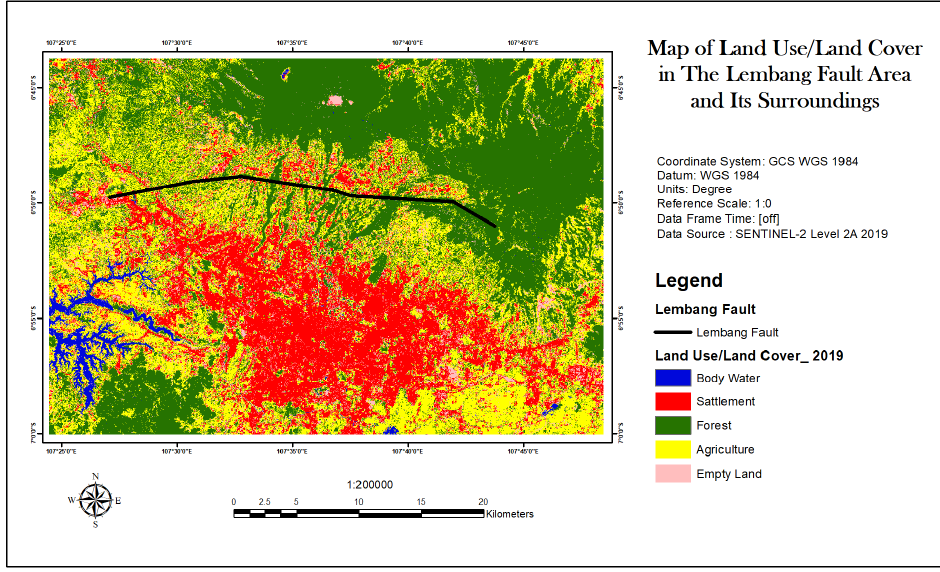
Figure 2. Land use/land cover of Lembang Fault in 2019. In 2019, the land use/land cover of the Lembang Fault area was dominated by forest (44.55%) and agricultural land (30.60%). Settlement areas coverage was 22.80%.